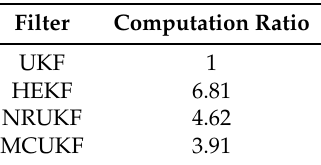
Table 6. Computation time